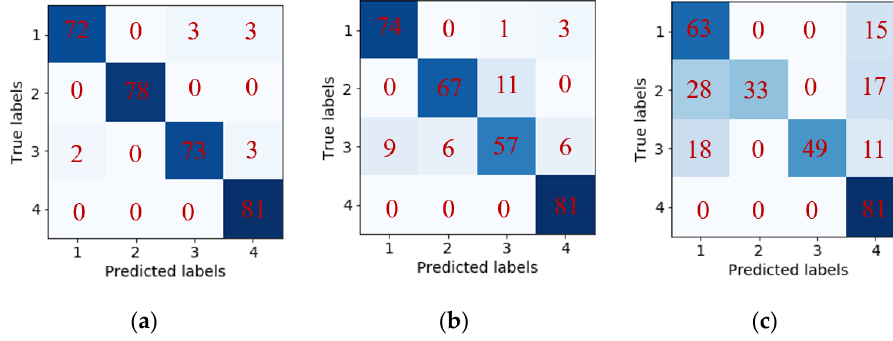
Figure 7. Classification result: confusion matrix ( a ) CLSTM; ( b ) MLP; ( c ) SVM.